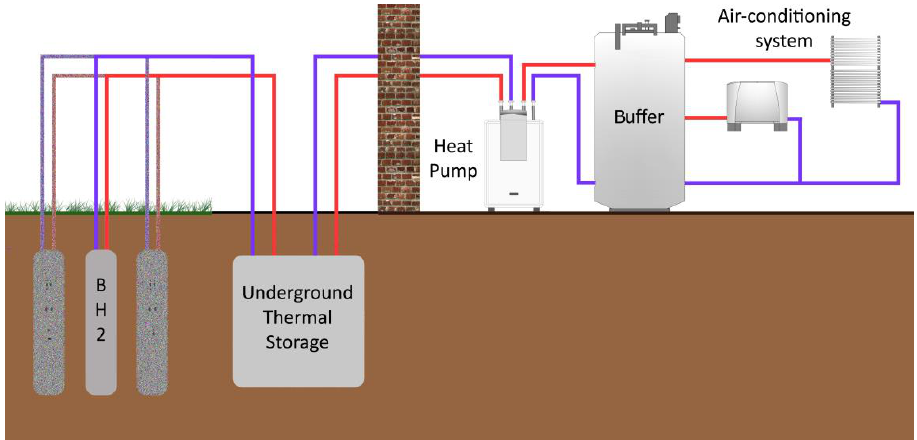
Figure 2. The prototype layout: alternative mode.